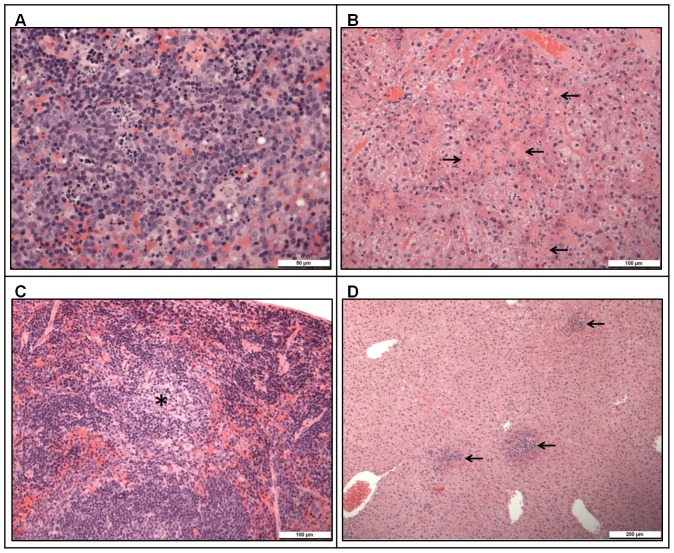
Tissue histology of A129 mice, 4 days after challenge with CCHFv.A129 mice were challenged with double the minimum lethal dose of CCHFv, 14 days after booster vaccination with MVA 1974 (A–B) or MVA-GP (C–D). Four days after challenge, sections of spleen (A, C) and liver (B, D) were fixed, HE stained, and examined for pathology. More severe pathology was found in mice that received MVA 1974, compared to those that received MVA-GP. (A) Marked lymphocyte loss with prominent apoptotic bodies, and infiltration by macrophages. (B) Marked, multifocally extensive hepatocyte necrosis (arrows). (C) A single infiltration of macrophages in the white pulp (asterisk) (scored minimal). (D) Scattered, multifocal areas of hepatocellular necrosis with a mixed inflammatory cell infiltrate (arrows) (scored moderate).